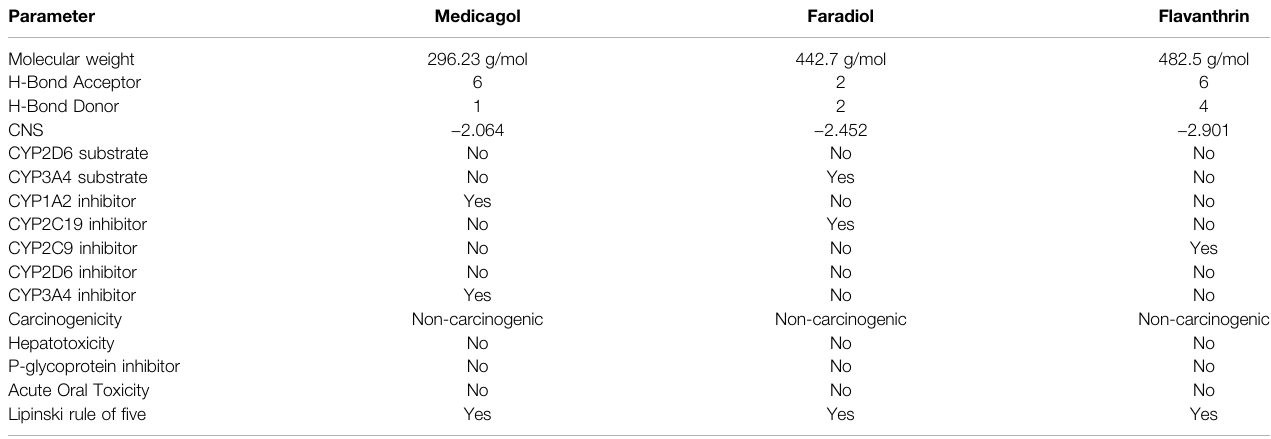
TABLE 2 | Pharmacological pro fi les of the top three potential candidates derived from the SwissADME, admetSAR, and pKCSM webservers. Parameter